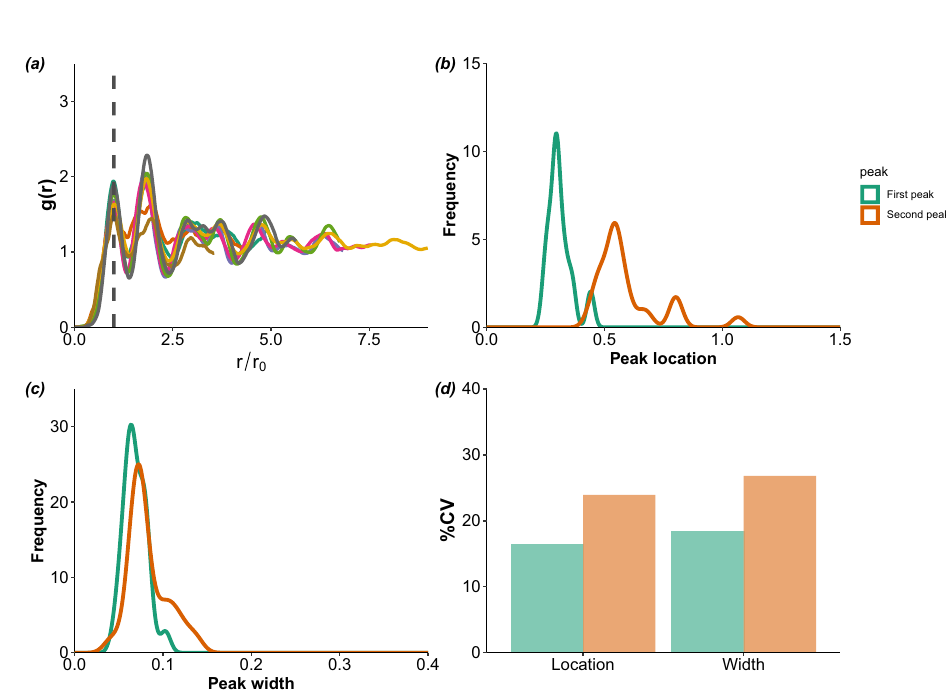
Figure 3. ( a ) Pair correlation function of vertices from 10 randomly chosen nests, showing a significant overlap around the first and second peaks; beyond the third peak, the positioning of vertices approaches random distribution (approaching 1). The x-axis is scaled ( r / r 0 ) such that the first peak is at the same x-value for all nests. Each coloured line represents one nest. Distribution of ( b ) locations and ( c ) widths obtained by Gaussian approximation of first and second peaks of the pair correlation function of 25 nests. ( d ) Relative difference in coefficient of variation (CV) of locations and widths of first and second peaks. Each CV value depicts variation within the